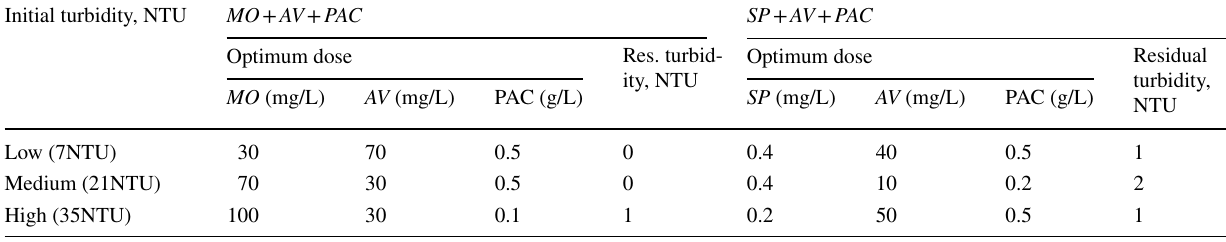
Fig. 6 Effect on settling time by use of a MO , b SP with and without micro-sand and